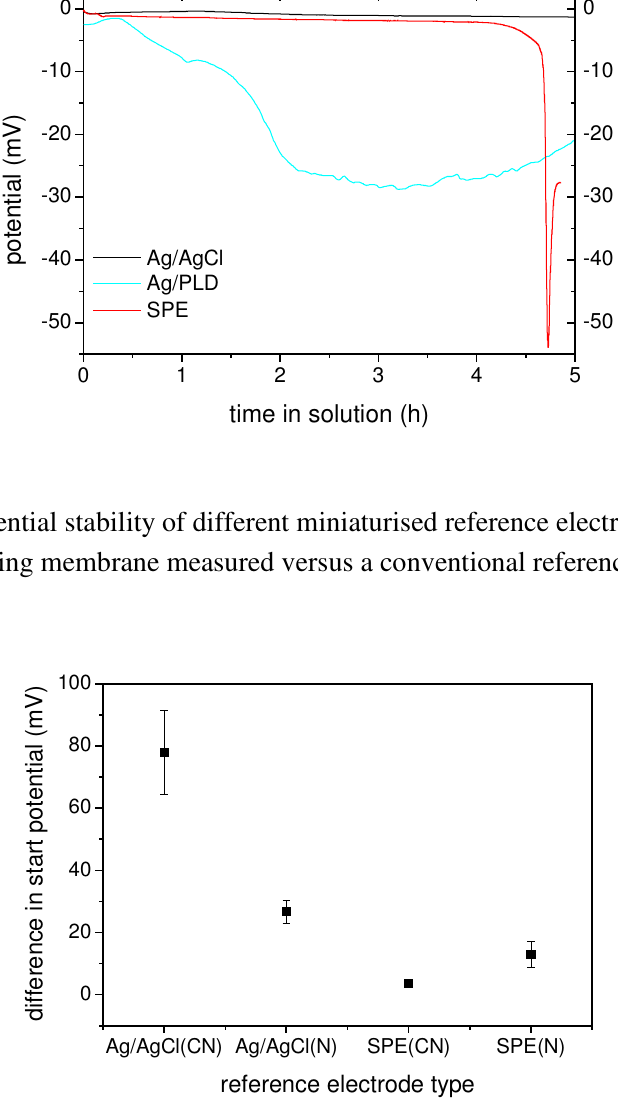
Figure 4. Difference in start potential of different miniaturised reference electrodes with KCl- containing membrane and protective